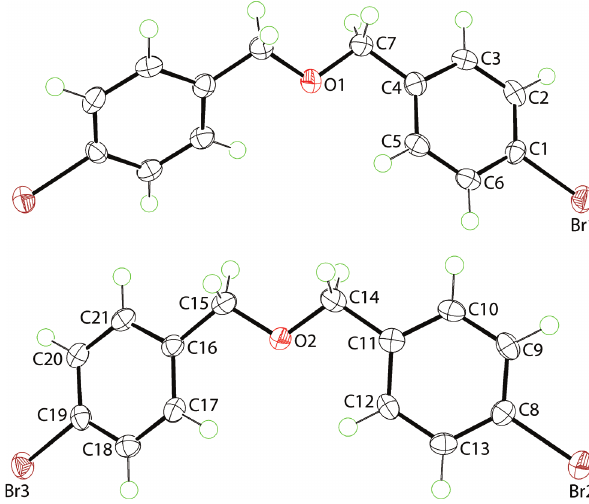
Table 1: Data collection and handling.